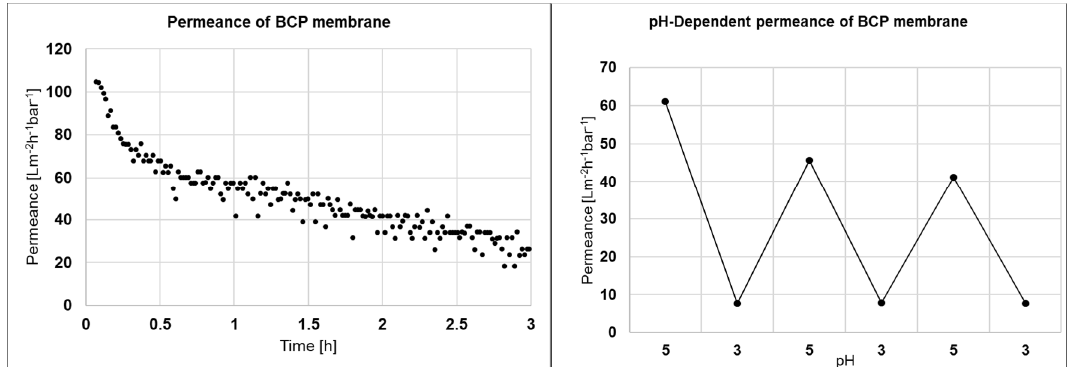
Figure 6. Permeance of a BCP membrane made from PS 83 - b -P4VP 1788 solution in dioxane sprayed with airbrush on a PVDF support using a membrane casting machine ( left ) and pH-dependent permeance of the same membrane ( right ).